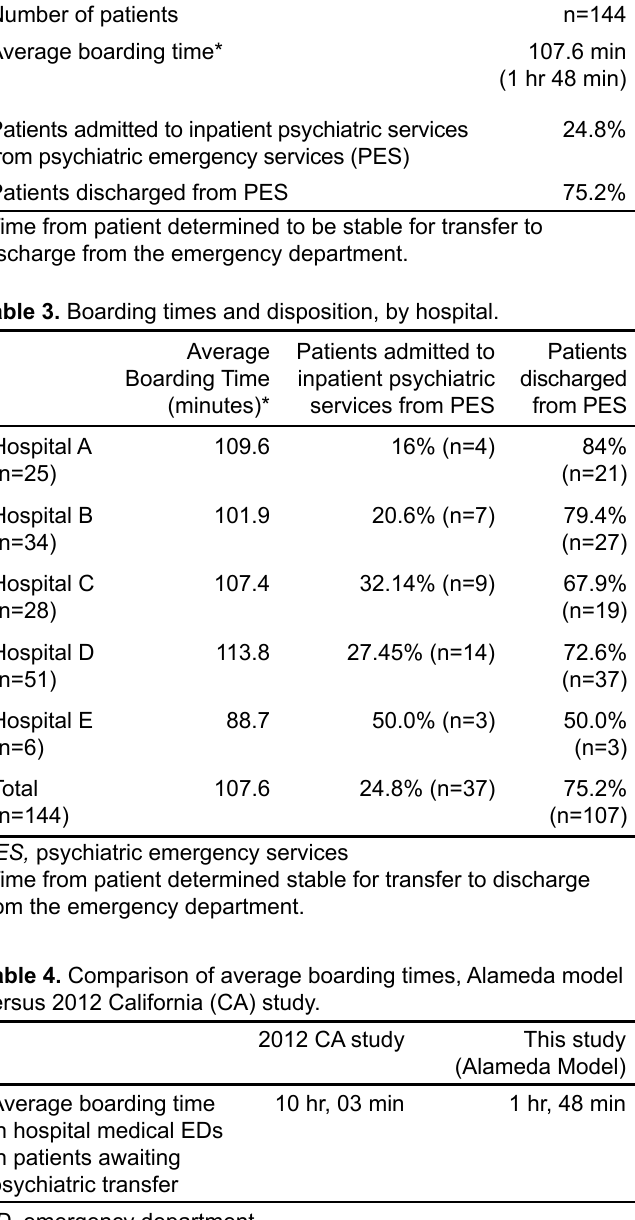
Table 2. Boarding time and psychiatric hospitalization rates under the Alameda Model.